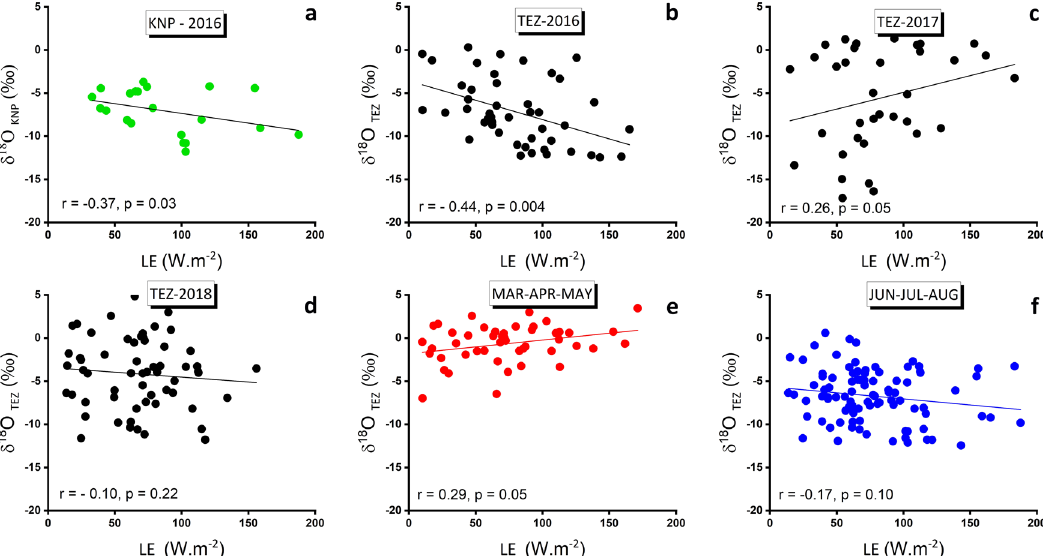
Fig. 3 Relation between latent heat fl ux and precipitation δ 18 O. Scatter plots for LE and precipitation δ 18 O for a Kaziranga forest (the year 2016), water sampling site was close to the eddy-covariance tower (~1 km). b Tezpur site (year 2016), c Tezpur site (year 2017), d Tezpur site (year 2018). Barring 2017, in general, an inverse correlation was found in all the cases. The remaining plots in the lower panel show the same scatter plot but on a seasonal time scale combining all year data. e Premonsoon (March – April – May) and f monsoon (June – July – August) seasons. A positive trend in MAM is indicative of the presence of an increased number of heavier isotopes ( 18 O) in the water vapour fl ux relative to that of the JJA